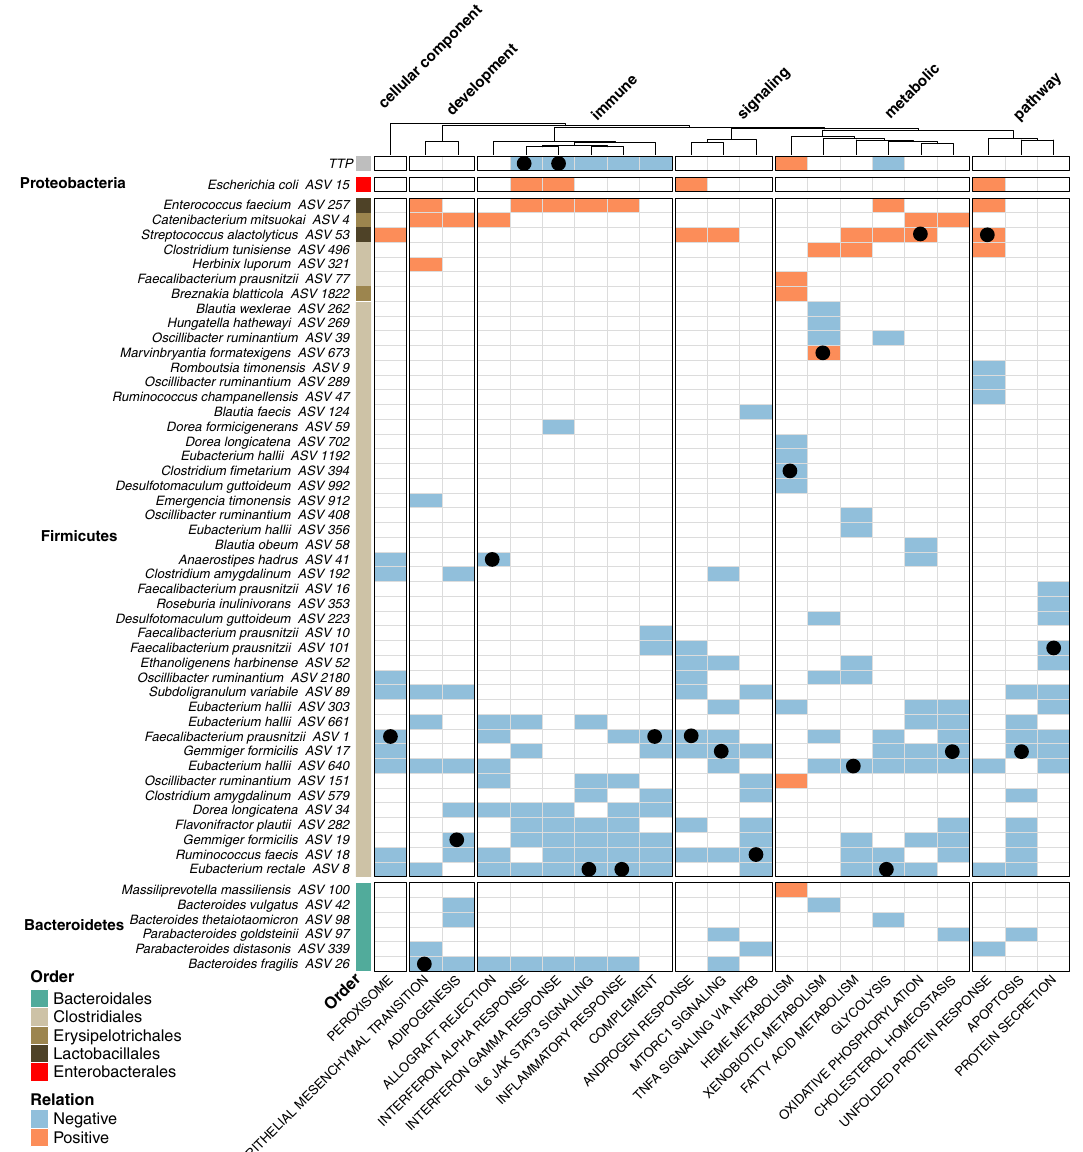
Fig. 6 Use of Random Forest Regression Modeling to search for associations between immune-related peripheral blood gene signatures and changes in gastrointestinal microbiota and TTP. The heatmap displays the sign of the derivative of the ALE curve (See Text). Blue/orange entries indicate features found to signi fi cantly associate with changes in a speci fi c in fl ammatory pathway. Blue indicates a negative relationship, while orange a positive. For each immune pathway, a pathway-ASV association was determined signi fi cant if the Benjamini – Hochberg false discovery rate (FDR) adjusted p-value from the permutated importance analysis was found to be less than 0.05. Black symbols are used to identify the modeling-identi fi ed top important predictor (i.e., the predictor that if missing would lead to highest increase in mean squared error between model predictions and observations) for each speci fi c host pathway. This analysis shows that reduction in TB burden and increased abundance of health-associated Cluster IV and XIVa Clostridia predicts in fl ammatory dampening. In contrast, increased abundance of oxygen-tolerant pathobionts including Enterococcus , Streptococcus , and E. coli predicts in fl ammatory exacerbation. A table reporting variable importance values, slope and intercepts from the ALE plot calculation and the related p values is provided in Supplementary Data 18. Source data are provided as a Source Data fi